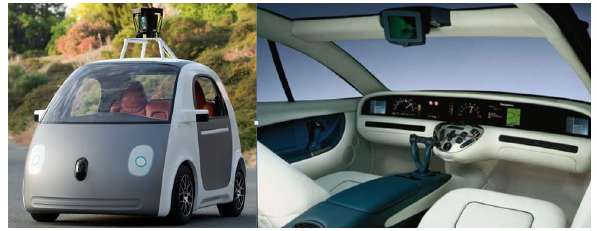
Figure 9: Google’s two-seater self-driving car prototype eliminates steering wheel, accelerator and brake